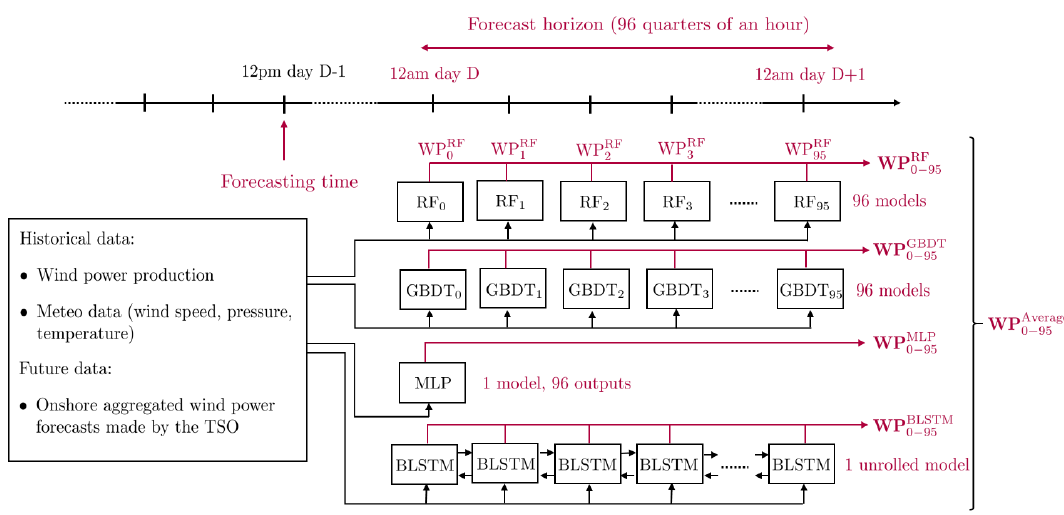
Figure 1. Wind power forecasting